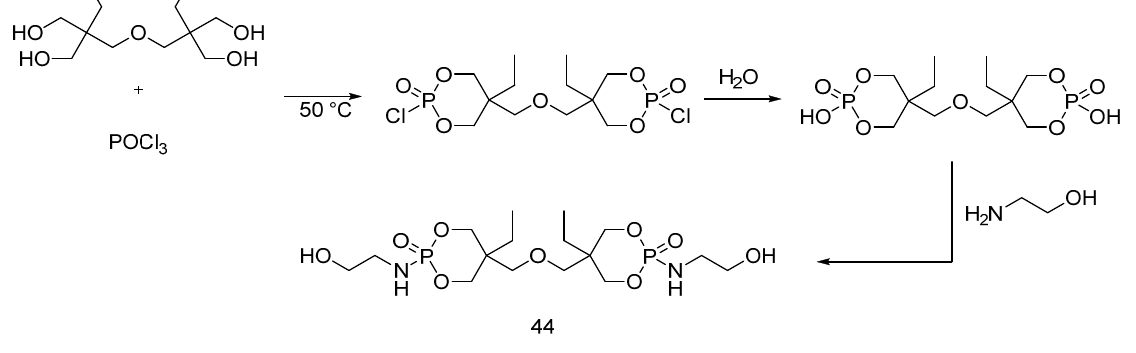
Figure 28. Representative schematic synthesis of ( 44 ).